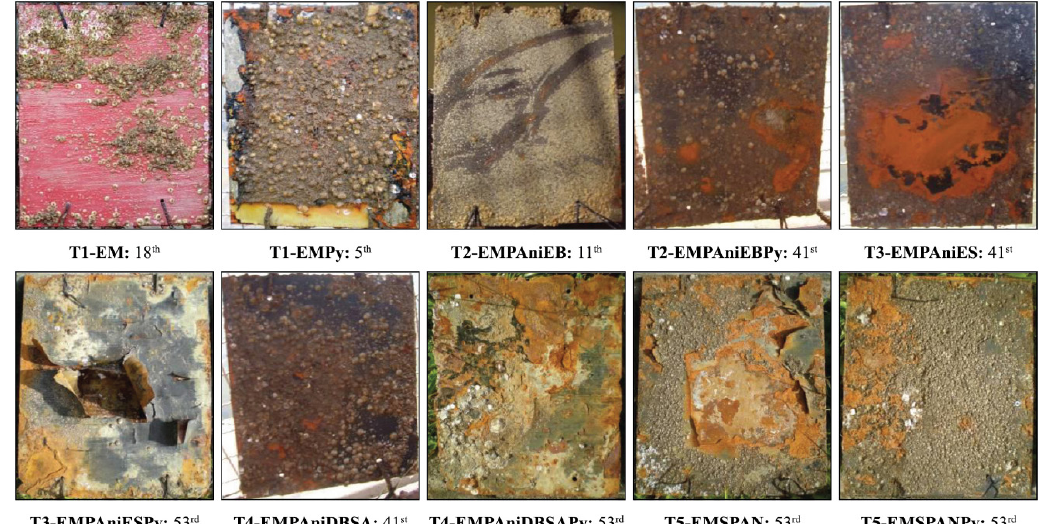
Figure 4. Appearance of steel plates coated with the paints prepared with the monocomponent epoxy resin and its time of immersion in the marine environment (Imbé - Brazil).